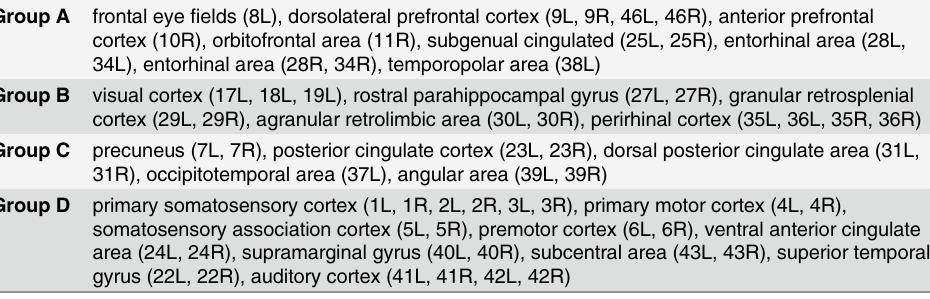
Table 1. Results from the dendrogram analysis for the WE task; four groups of sources were found to be common to the WE-IL and the WE-IT conditions in the upper alpha band. Group A frontal eye fi elds (8L), dorsolateral prefrontal cortex (9L, 9R, 46L, 46R), anterior prefrontal cortex (10R), orbitofrontal area (11R), subgenual cingulated (25L, 25R), entorhinal area (28L, 34L), entorhinal area (28R, 34R), temporopolar area (38L)